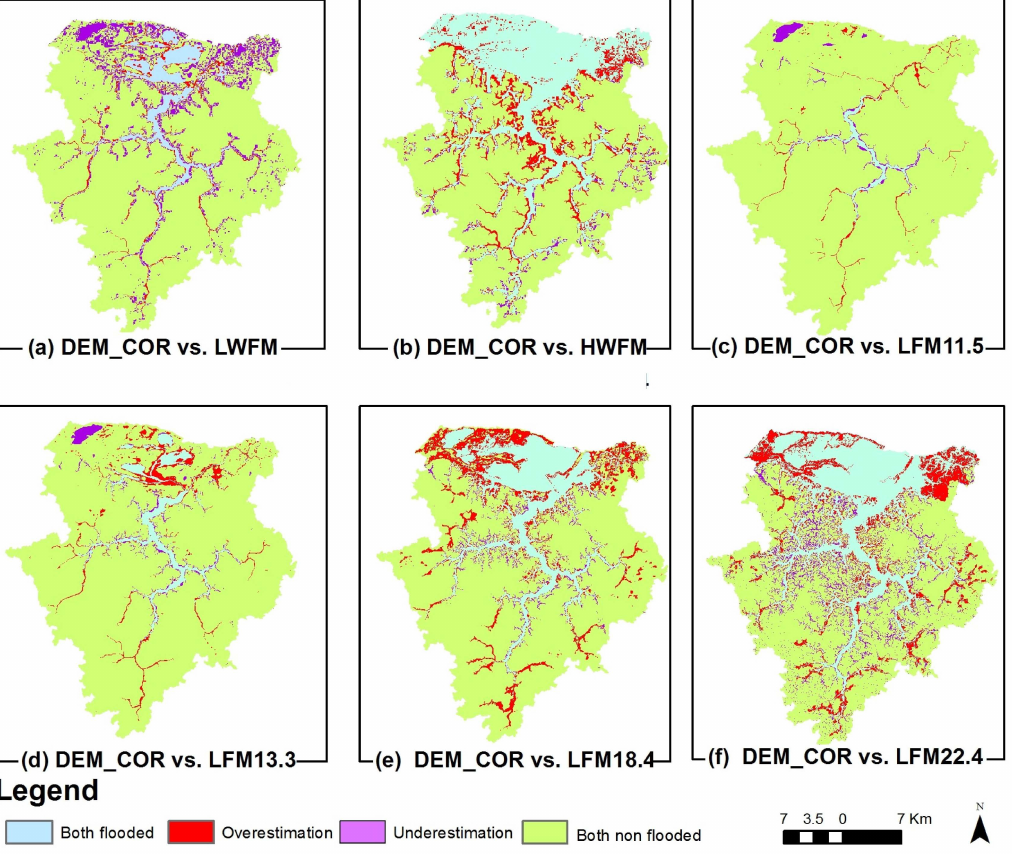
Figure 6. Comparison of inundation extent between DEM_COR and classification from JERS-1 and Landsat (For interpretation of the references to color in this figure legend, the reader is referred to the web version of this article). ( a ) DEM_COR vs. LWFM, ( b ) DEM_COR vs. HWFM ( c ) DEM_COR vs. LFM 11.5, ( d ) DEM_COR vs. LFM 13.3, ( e ) DEM_COR vs. LFM 18.4, ( f ) DEM_COR vs. LFM